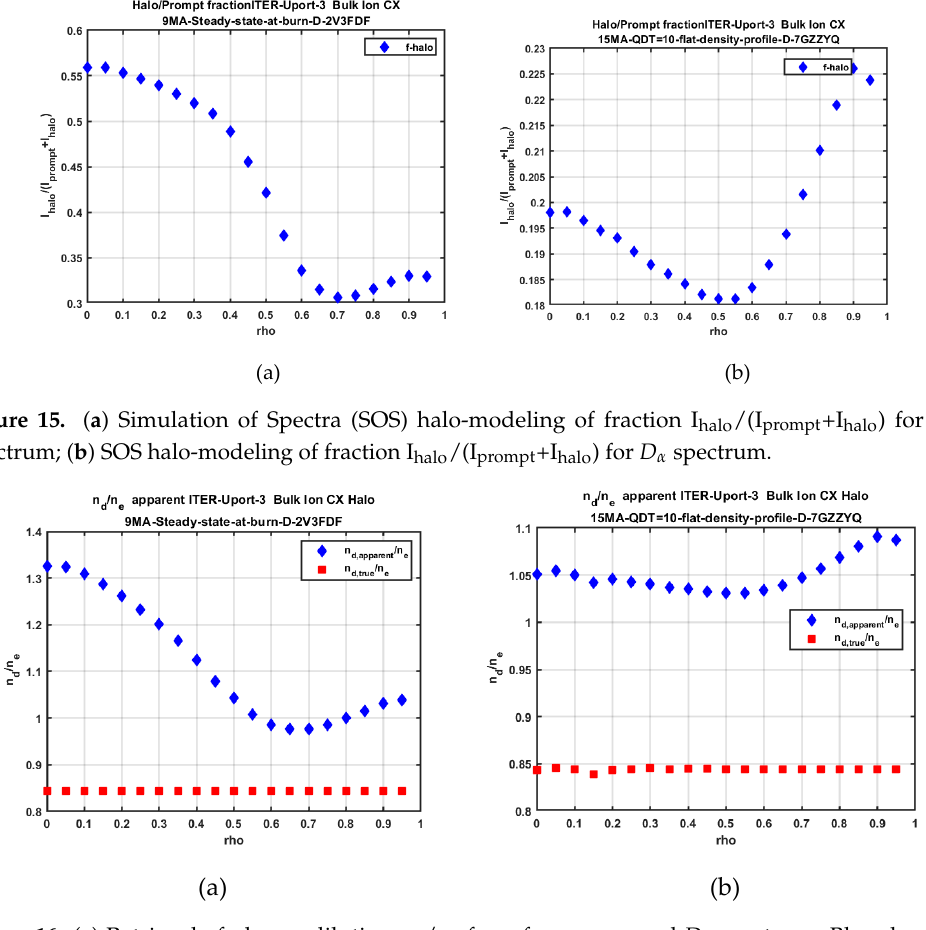
Figure 14. ( a ) D α Spectrum with prompt signal and comparison of Gaussian-like halo shape and